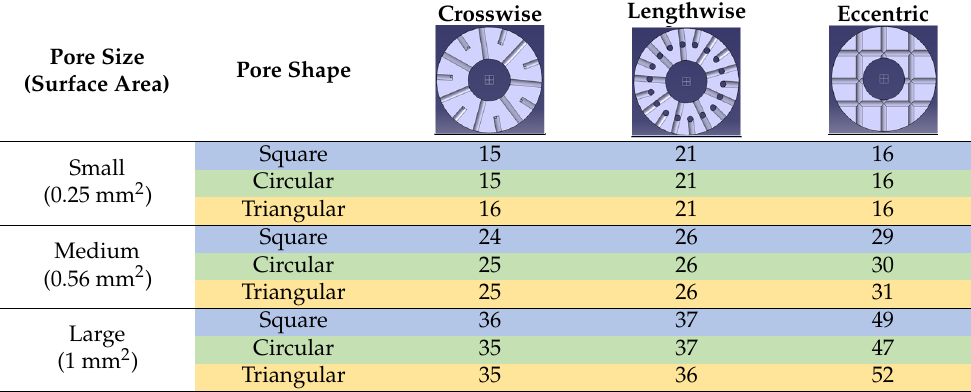
Table 1. The porosity in percentage (%) for each scaffold model.